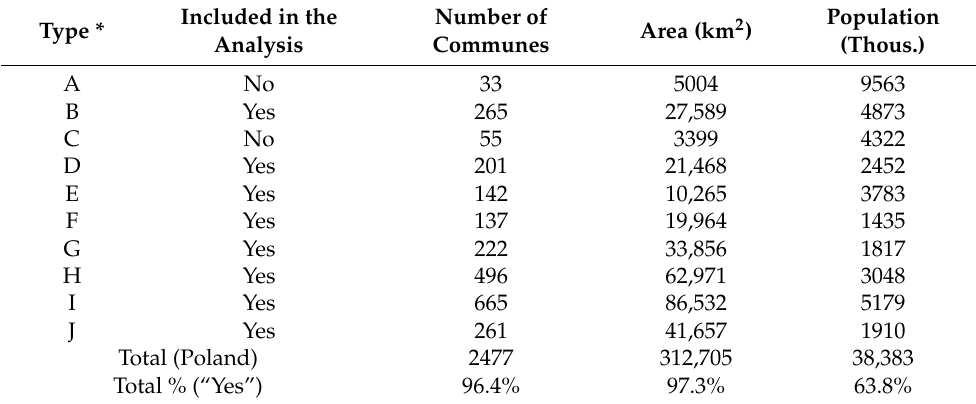
Table 1. Characteristics of the analysed communes (gminas) in Poland, for the year 2019. Population Included in the Number of Type * Area (km 2 ) (Thous.) Analysis Communes A No 33 5004 9563 B Yes 265 27,589 4873 C No 55 3399 4322 D Yes 201 21,468 2452 E Yes 142 10,265 3783 F Yes 137 19,964 1435 G Yes 222 33,856 1817 H Yes 496 62,971 3048 I Yes 665 86,532 Yes 261 1910 Total (Poland) 96.4% 97.3%